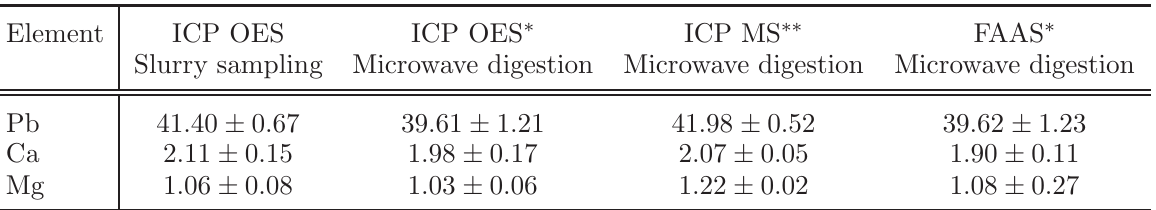
Table 5 Comparison of techniques (mg kg − 1